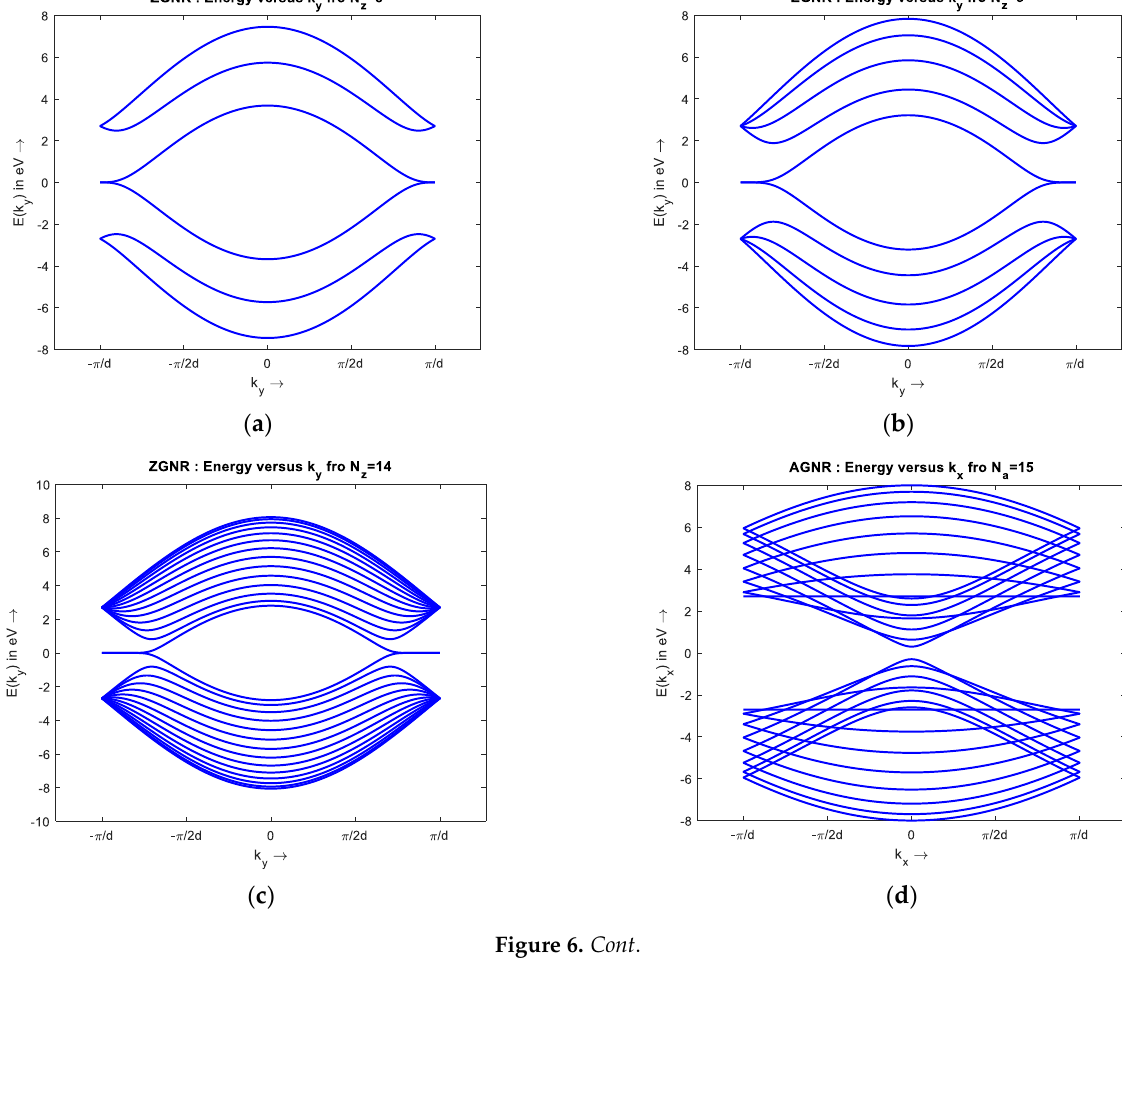
( f ) Figure 6. Band structure of ( a – c ) ZGNR, Nz = 3, 5, 14, and ( d – f ) AGNR, Na = 15, 4, and 8. 3.2. NEGF Modeling of GFET To simulate devices, the graphene FET at IBM with gate length 40 nm is used [28], when the gate oxide is 𝑆𝑖 3 𝑁 4 with an oxide thickness of 10 nm. The pure graphene chan- nel length is 40 nm, and the metals of drain and source are palladium. GFET potential values and corresponding transmission spectrum of the proposed method agree well with Low’s method [15] , as shown in Figure 7. Figure 7 shows the transmission that is contrib- uted by the thermionic current, the source-channel, and the channel-drain tunneling cur- rent. The transmission is non-zero for all energies, which shows the device is gapless, but there are minimum values that separate the regions in the transmission spectrum. Accord- ing to 𝐼 𝑑 /𝑉 𝑔𝑠 and 𝐼 𝑑 /𝑉 𝑑𝑠 shown in Figure 8, for negative and positive 𝑉 𝑔𝑠 Values the neg- ative differential resistance (NDR) and positive resistance appeared, respectively. These effects in current/voltage characteristics are agreed well with other simulations [29 – 31] and experimental results [32,33]. The above results show that the formalization and as- sumptions considered for GFET are acceptable.